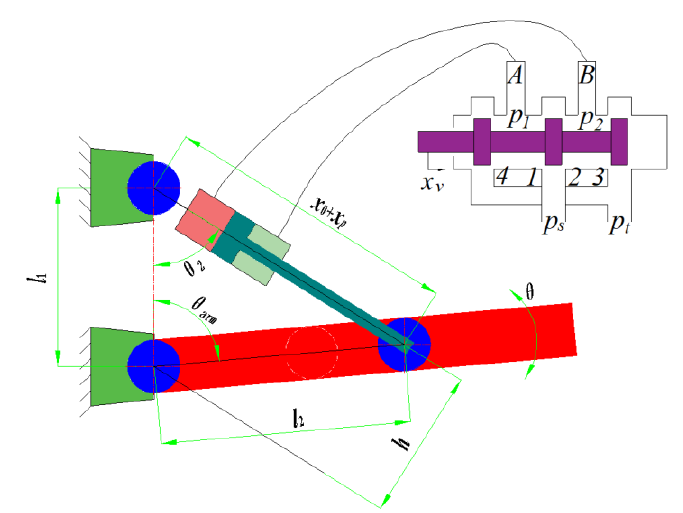
Figure 2. DOFs of the exoskeleton.